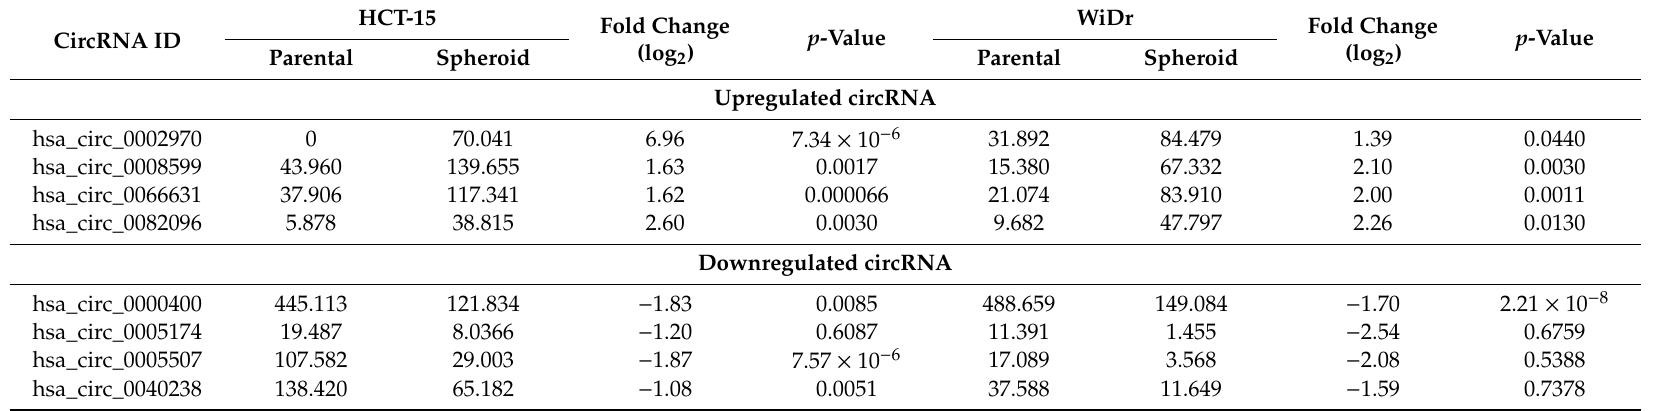
Table 1. Top four di ff erential expressed circRNAs in the spheroidal CRC.